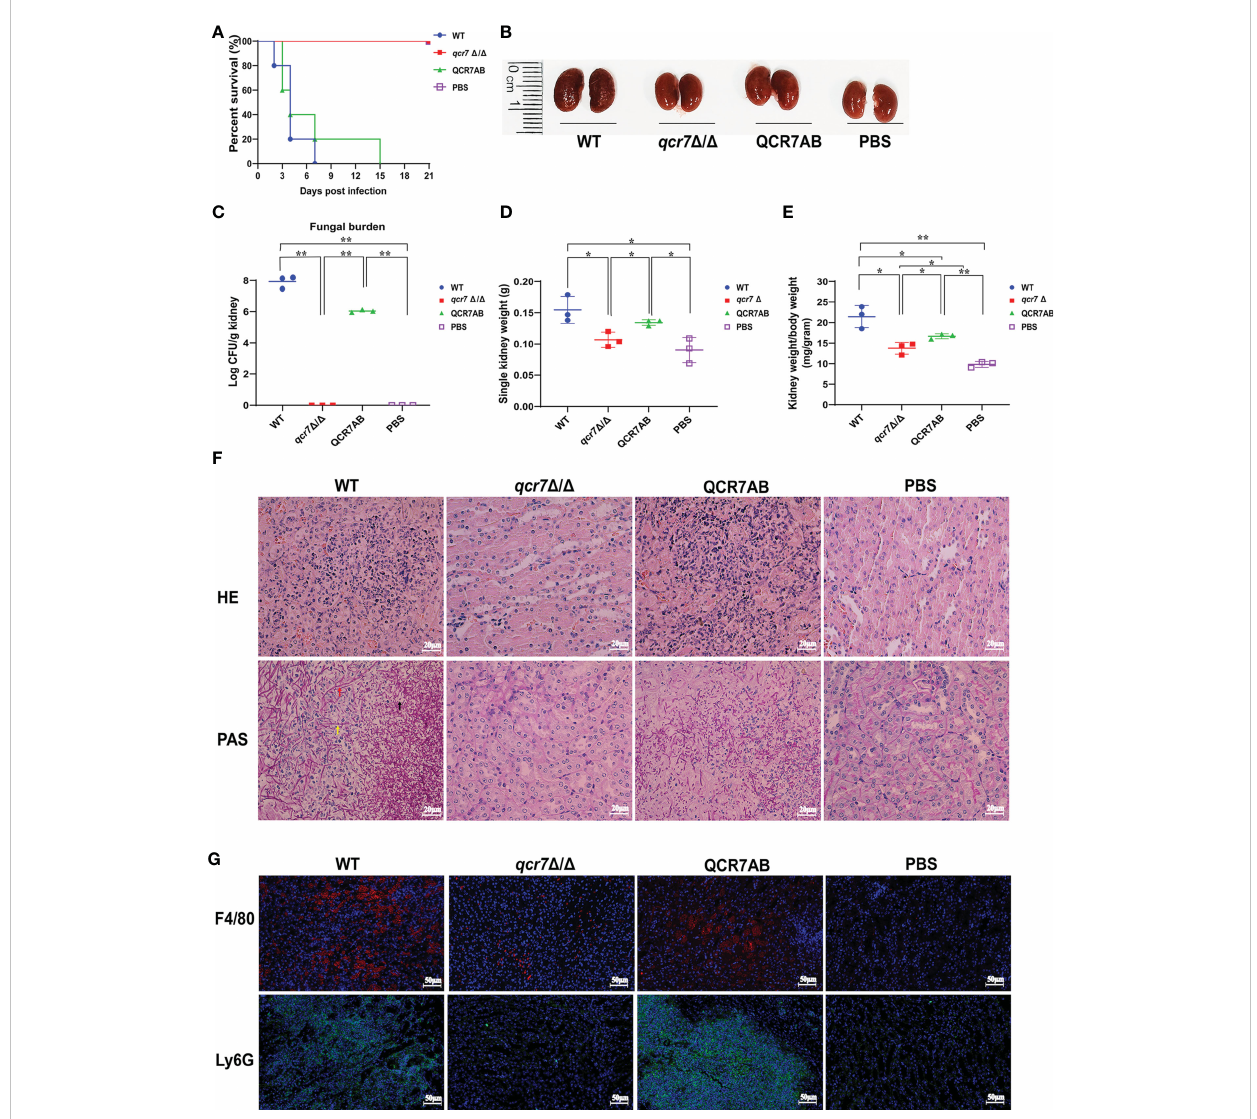
FIGURE 2 QCR7 mutant attenuates the virulence of C albicans infection in vivo . (A) Mice survival following illness initiation with the injection of 5 × 10 5 C albicans cells. (B) Comparison of mouse kidneys was conducted by injection with WT, qcr7 D / D , and QCR7AB. Mice were sacri fi ced 48h after the C albicans infection. (C – E) Fungal burden in the kidneys of mice injected with WT, qcr7 D / D , and QCR7AB ( p <0.0001 WT vs mutant). The mice were sacri fi ced 2 days after an intravenous injection with 5 × 10 5 CFU C albicans . Kidney weights were calculated as each mouse ’ s weight per gram of body weight ( p =0.0122 WT vs mutant). “ * ” represents p < 0.05 and “ ** ” represents p < 0.01 for the WT vs. mutant strains. (F) Representative hematoxylin – eosin- or periodic acid-Schiff-base-stained sections of kidney-tissue samples from three experiments. (G) Immuno fl uorescence image showing the biodistribution of F4/80 (red) and Ly6G (green) in the renal of mice infected with Candida albicans . The nuclei were stained blue by DAPI. Scale bar = 50 m m. Hyphae (red arrow), pseudo-hyphae (yellow arrow), and spores (black